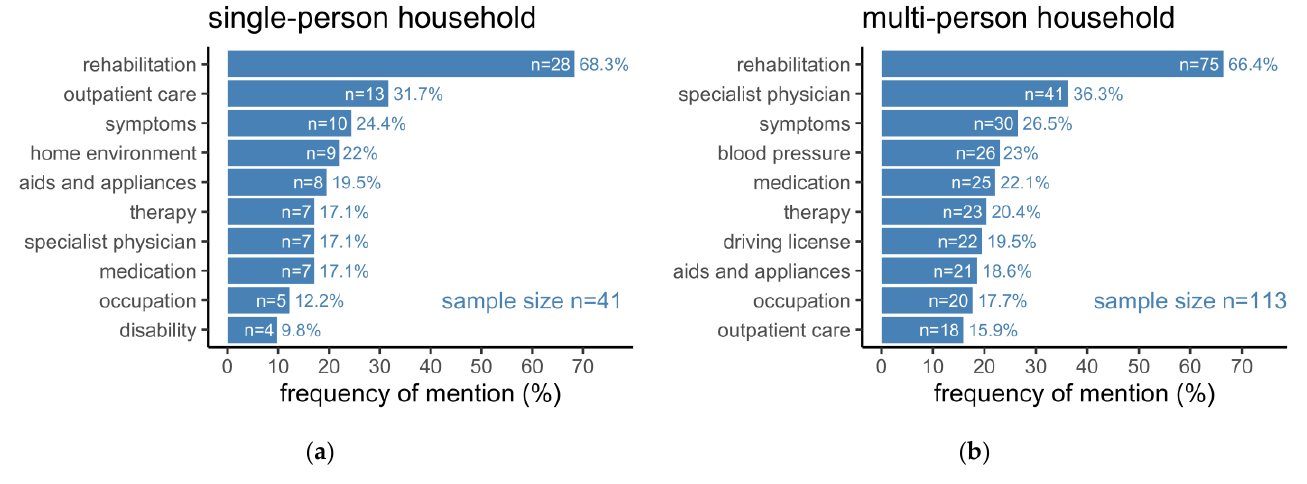
Figure 4. ( a ) Topics mentioned by patients living in a single-person household; ( b ) Topics mentioned by patients living in a household with at least one more person. Bars represent the number of patients (n) who mentioned a specific topic. Added rates represent the percentage of patients (%) with respect to the underlying sample size.